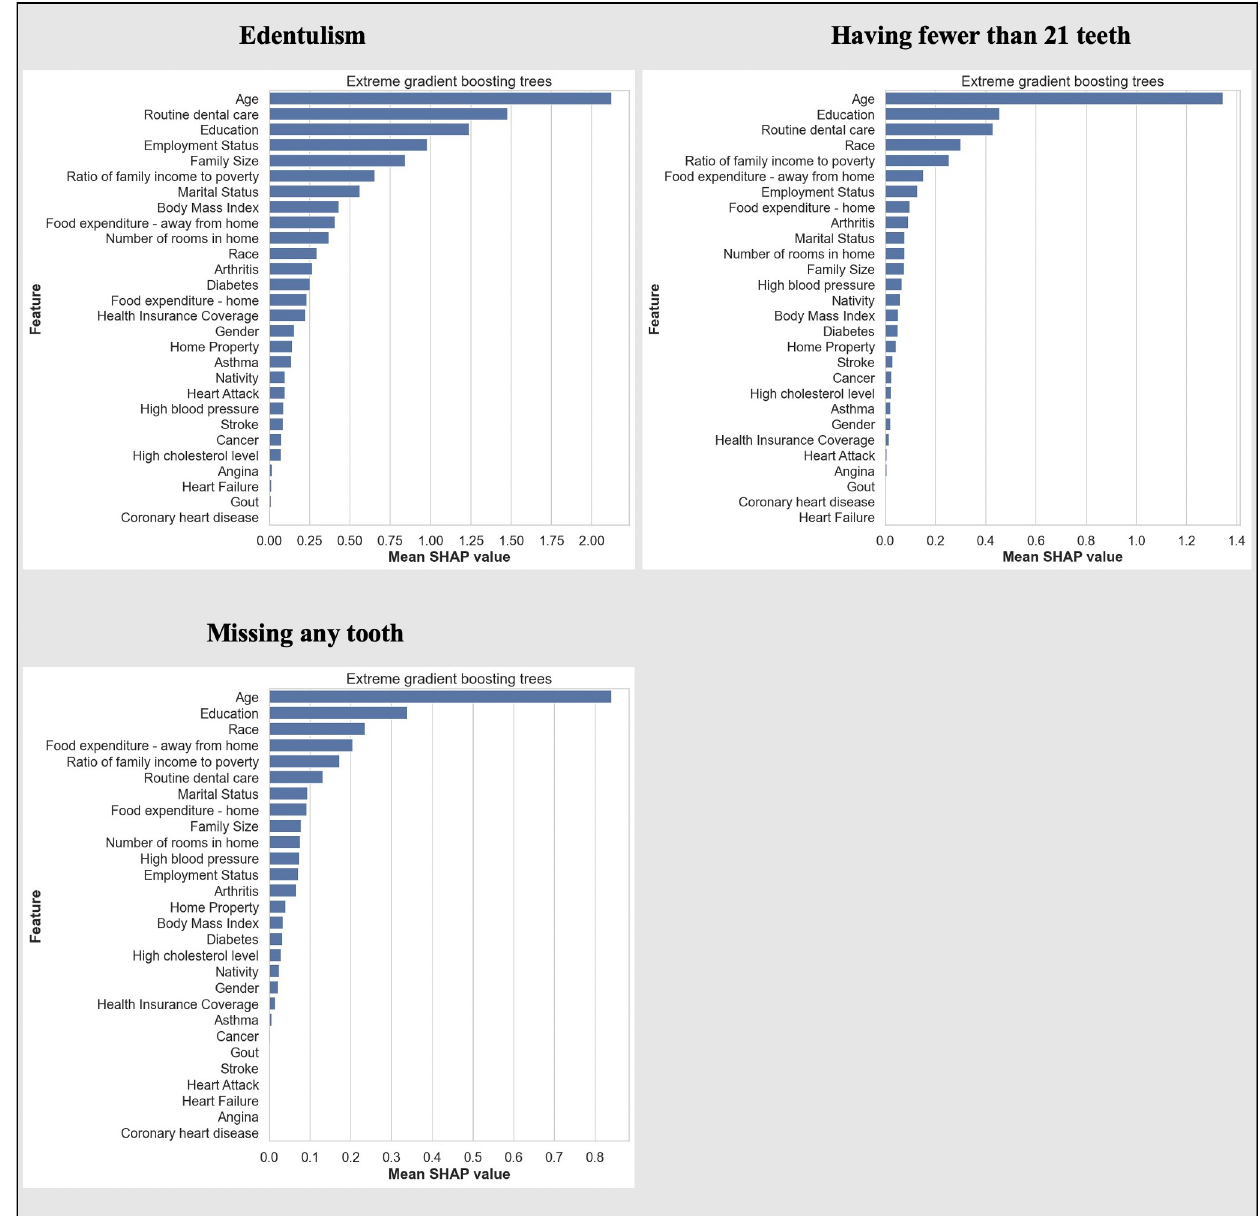
Fig 3. Variable importance plot in the extreme gradient boosting trees models for each outcome.